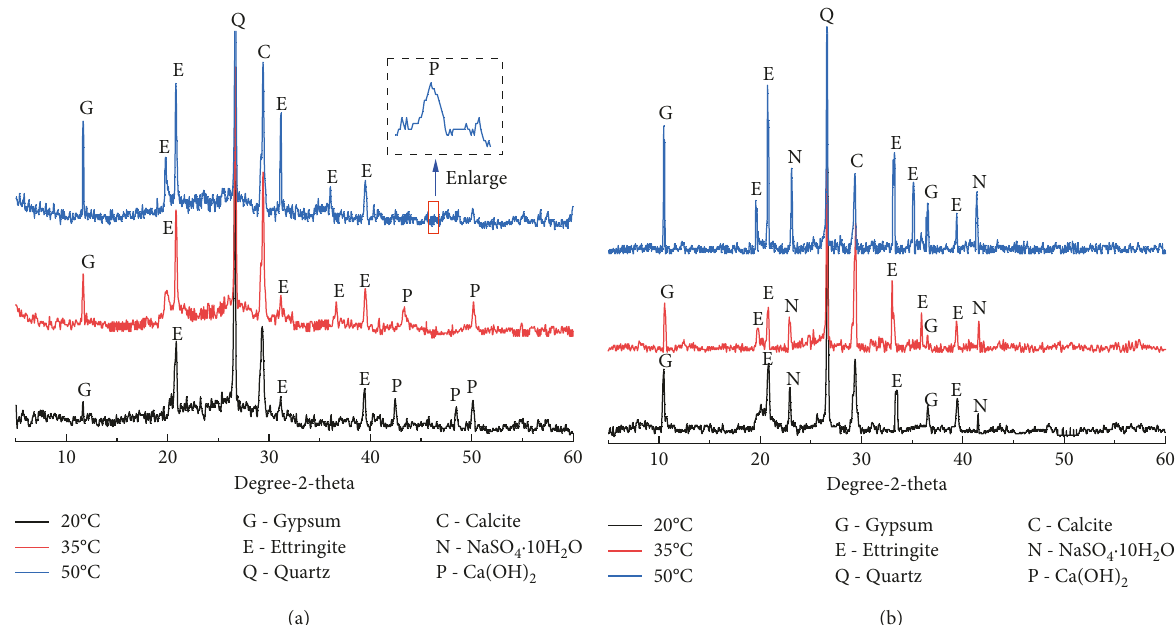
Figure 6: XRD diffraction analysis of CPB at a solution concentration of 7%: (a) 7d and (b)